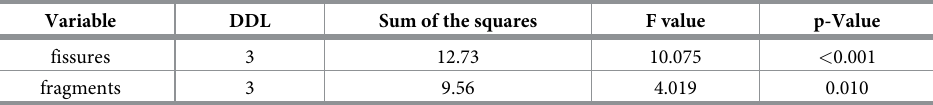
Table 1. Effect of fragments and fissures from charring experimenton on temperature (ANOVA).